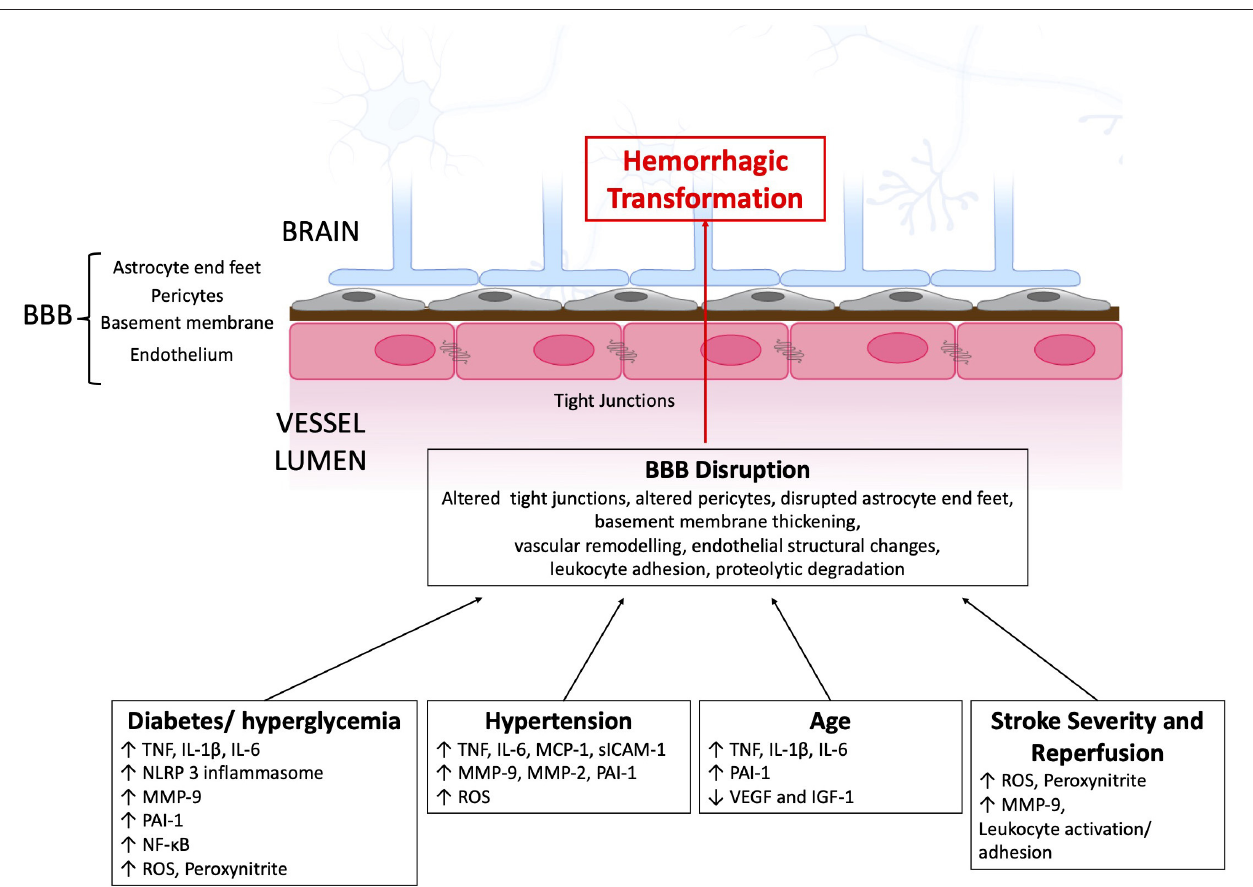
FIGURE 1 | Immune pathways contributing to BBB disruption and subsequent HT after AIS. BBB, blood-brain barrier; IGF-1, insulin-like growth factor 1IL, interleukin; MCP-1, monocyte chemoattractant protein 1; MMP, matrix metalloproteinase; NF- κ B, nuclear factor- κ B; NLRP3, NOD-, LRR- and pyrin domain-containing protein 3; PAI-1, plasminogen activator inhibitor-1; ROS, reactive oxygen species; TLR, toll like receptor; TNF, tumor necrosis factor; VEGF, vascular endothelial growth